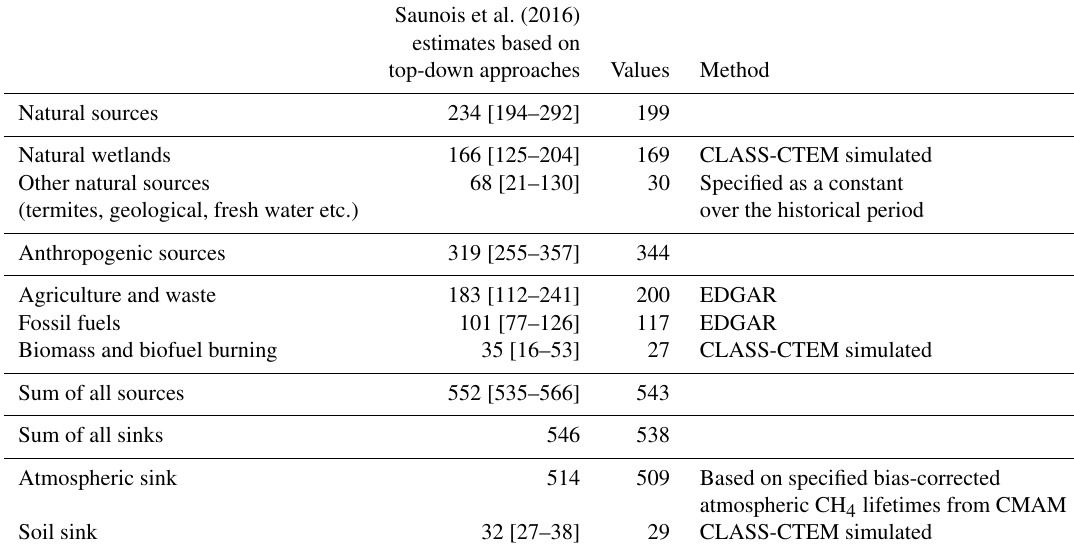
Table 3. Comparison of the components of the present day methane budget based on this study with those from Saunois et al. (2016) (based on synthesis of published studies). The values used in this study are averaged for the period 2000–2008 (as the last year of the version of EDGAR emissions used is 2008) while Saunois et al. (2016) values correspond to the 2000–2009